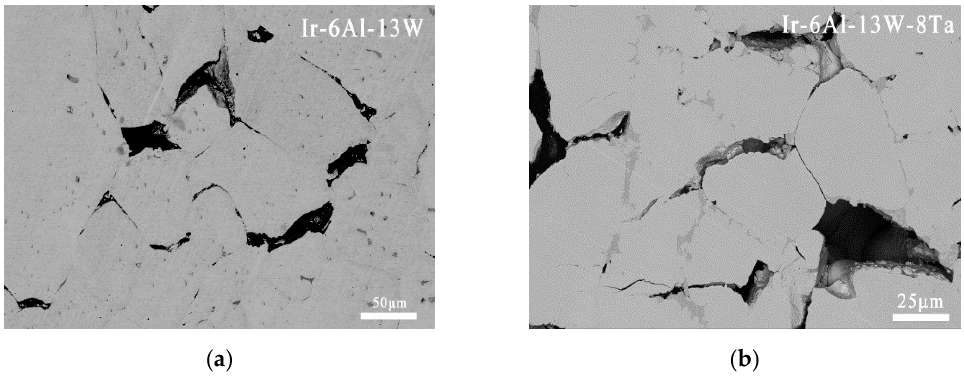
Figure 8. BSE images of the vertical cross section after 1300 °C compressions: ( a ) Ir–6Al–13W and ( b ) Ir–6Al–13W–8Ta alloys.